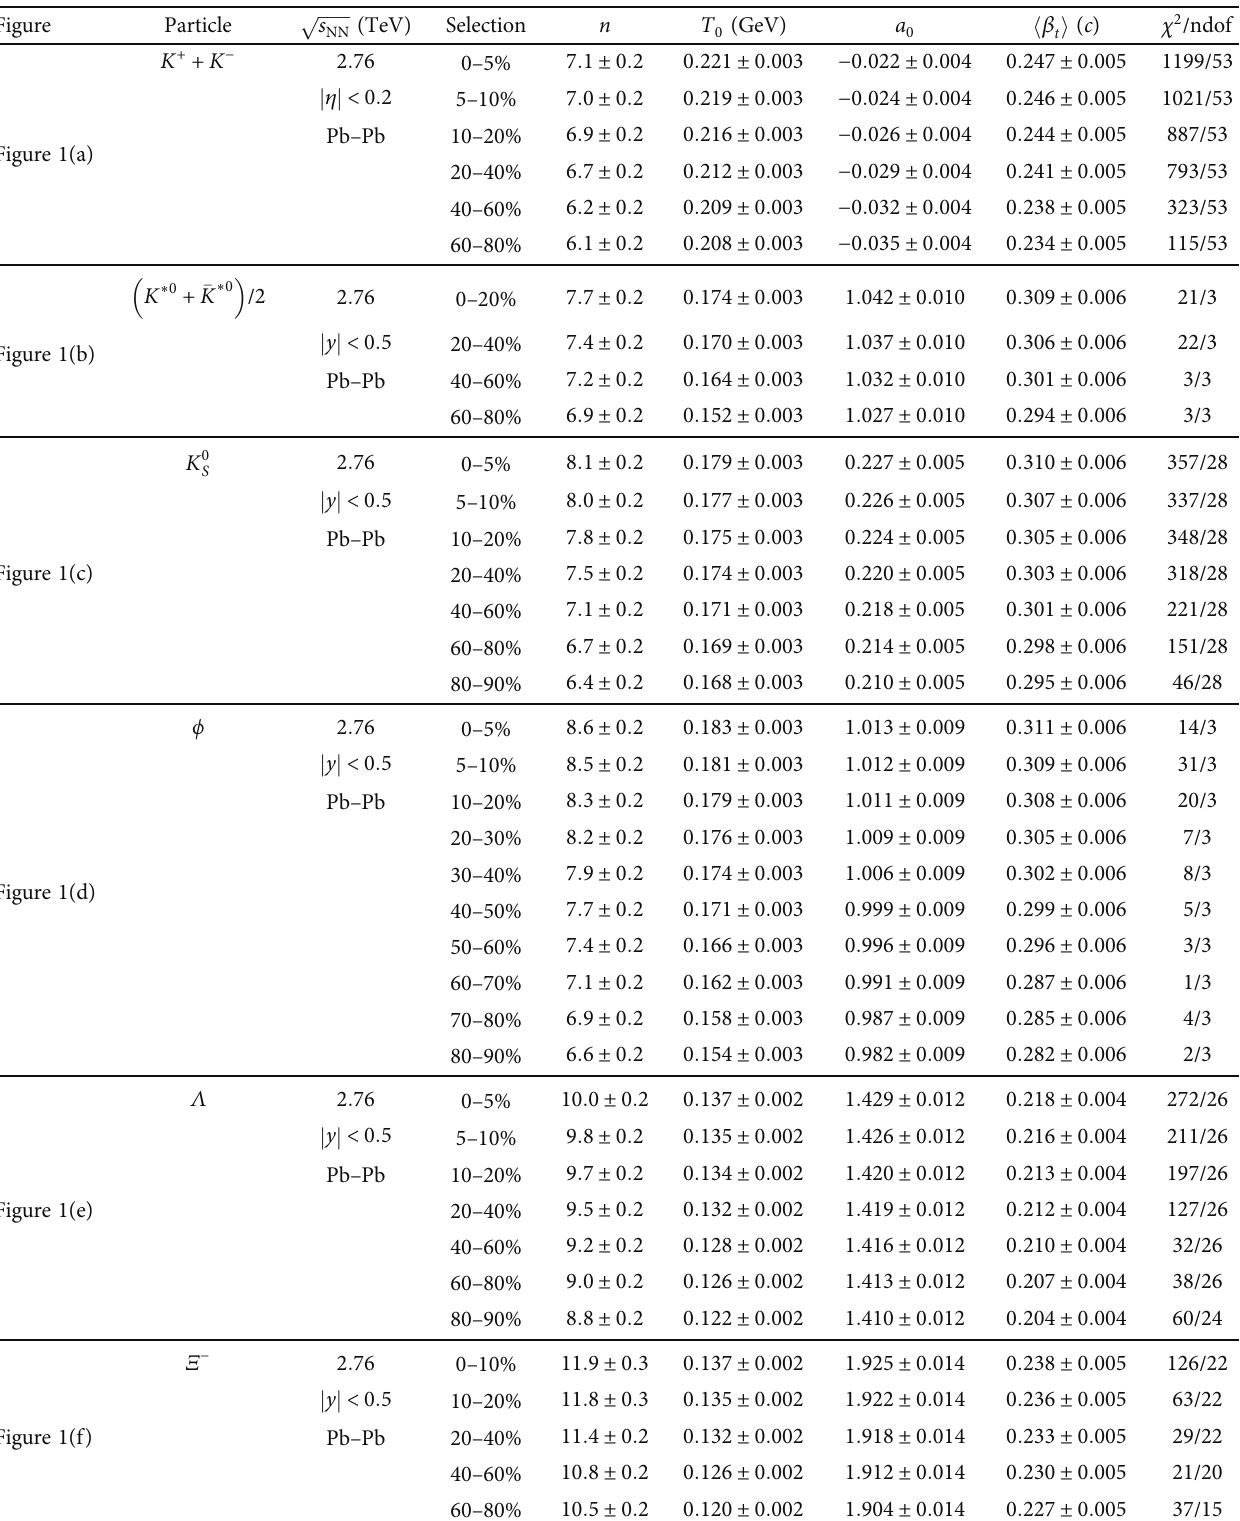
Table 1: Values of n , T